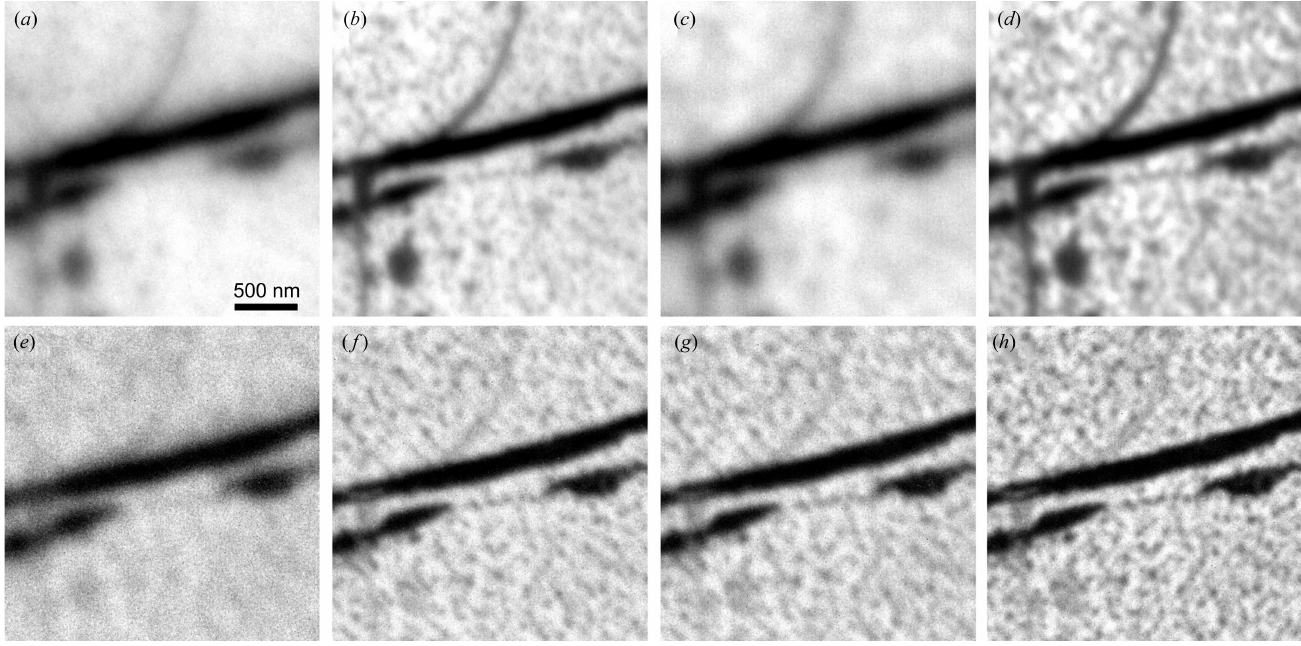
Figure 9 Space-charge effects manifested in the XPEEM images obtained under different conditions. Top row: secondary XPEEM images: ( a ) high photon flux of 4.2 (cid:6) 10 13 photons s (cid:3) 1 , ( b ) low photon flux of 1.4 (cid:6) 10 13 photons s (cid:3) 1 in the mirror-off mode, ( c ) same as ( b ) but in the mirror-on mode, ( d ) same as ( c ) with insertion of the SAA (100 m m). Lower row: Si 2 p core-level XPEEM images, ( e ) same as ( c ), ( f ) with the SAA inserted, ( g ) with the knife aperture inserted (no SAA), and ( h ) with both the SAA and the knife inserted. All XPEEM images presented are 2.5 m m (cid:6) 2.5 m m, cropped from raw images with FoV = 10 m m. The sample is monolayer graphene with a few bilayer islands grown on SiC (0001). In the mirror-on (mirror-off) mode, the 70 m m (30 m m) CA was always used. The photon energy used for all images was 150 eV. The integration time for ( a )–( d ) was 3.2 s and ( e )–( h ) was 320